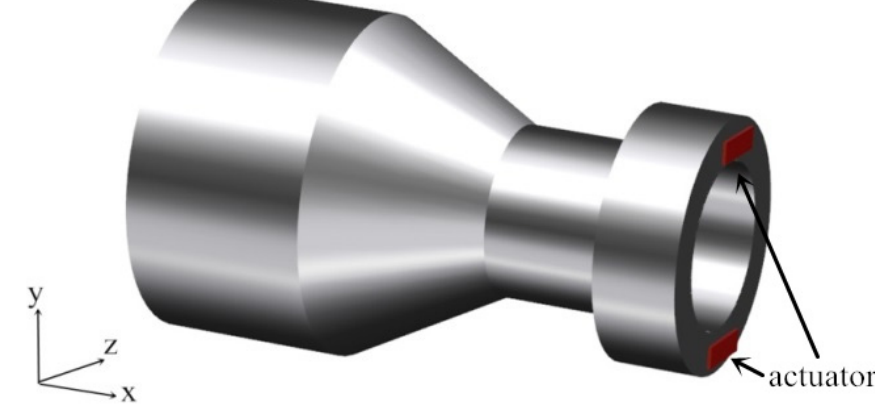
Figure 1. Nozzle and actuators arrangements.